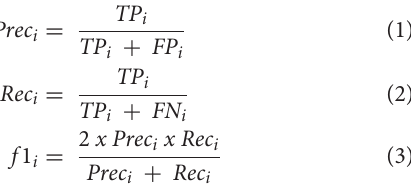
Frontiers in Medicine |